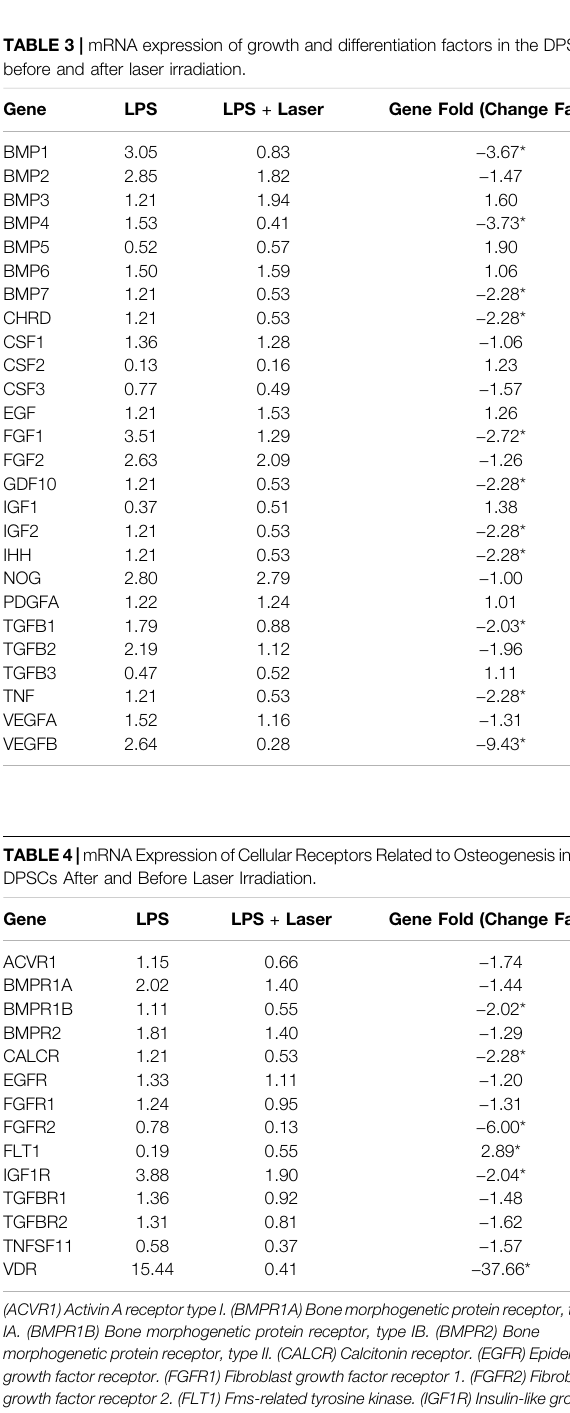
(ACVR1)ActivinAreceptortypeI.(BMPR1A)Bonemorphogeneticproteinreceptor,type IA. (BMPR1B) Bone morphogenetic protein receptor, type IB. (BMPR2) Bone morphogeneticprotein receptor,type II. (CALCR)Calcitonin receptor.(EGFR) Epidermal growth factor receptor.(FGFR1)Fibroblast growth factor receptor1. (FGFR2)Fibroblast growth factor receptor 2. (FLT1) Fms-related tyrosine kinase. (IGF1R) Insulin-like growth factor 1 receptor. (TGFBR1) Transforming growth factor, beta receptor 1. (TGFBR2) Transforming growth factor, beta receptor II. (TNFSF11) Tumor necrosis factor (ligand) superfamily, member 11. (VDR) Vitamin D (1.25- dihydroxyvitamin D3) receptor. The numbersrepresentthequanti fi cationofthegeneexpressionvariationinfoldchange,and the * represents genes that were modulated + or – 2.00-fold (p < 0.05) .